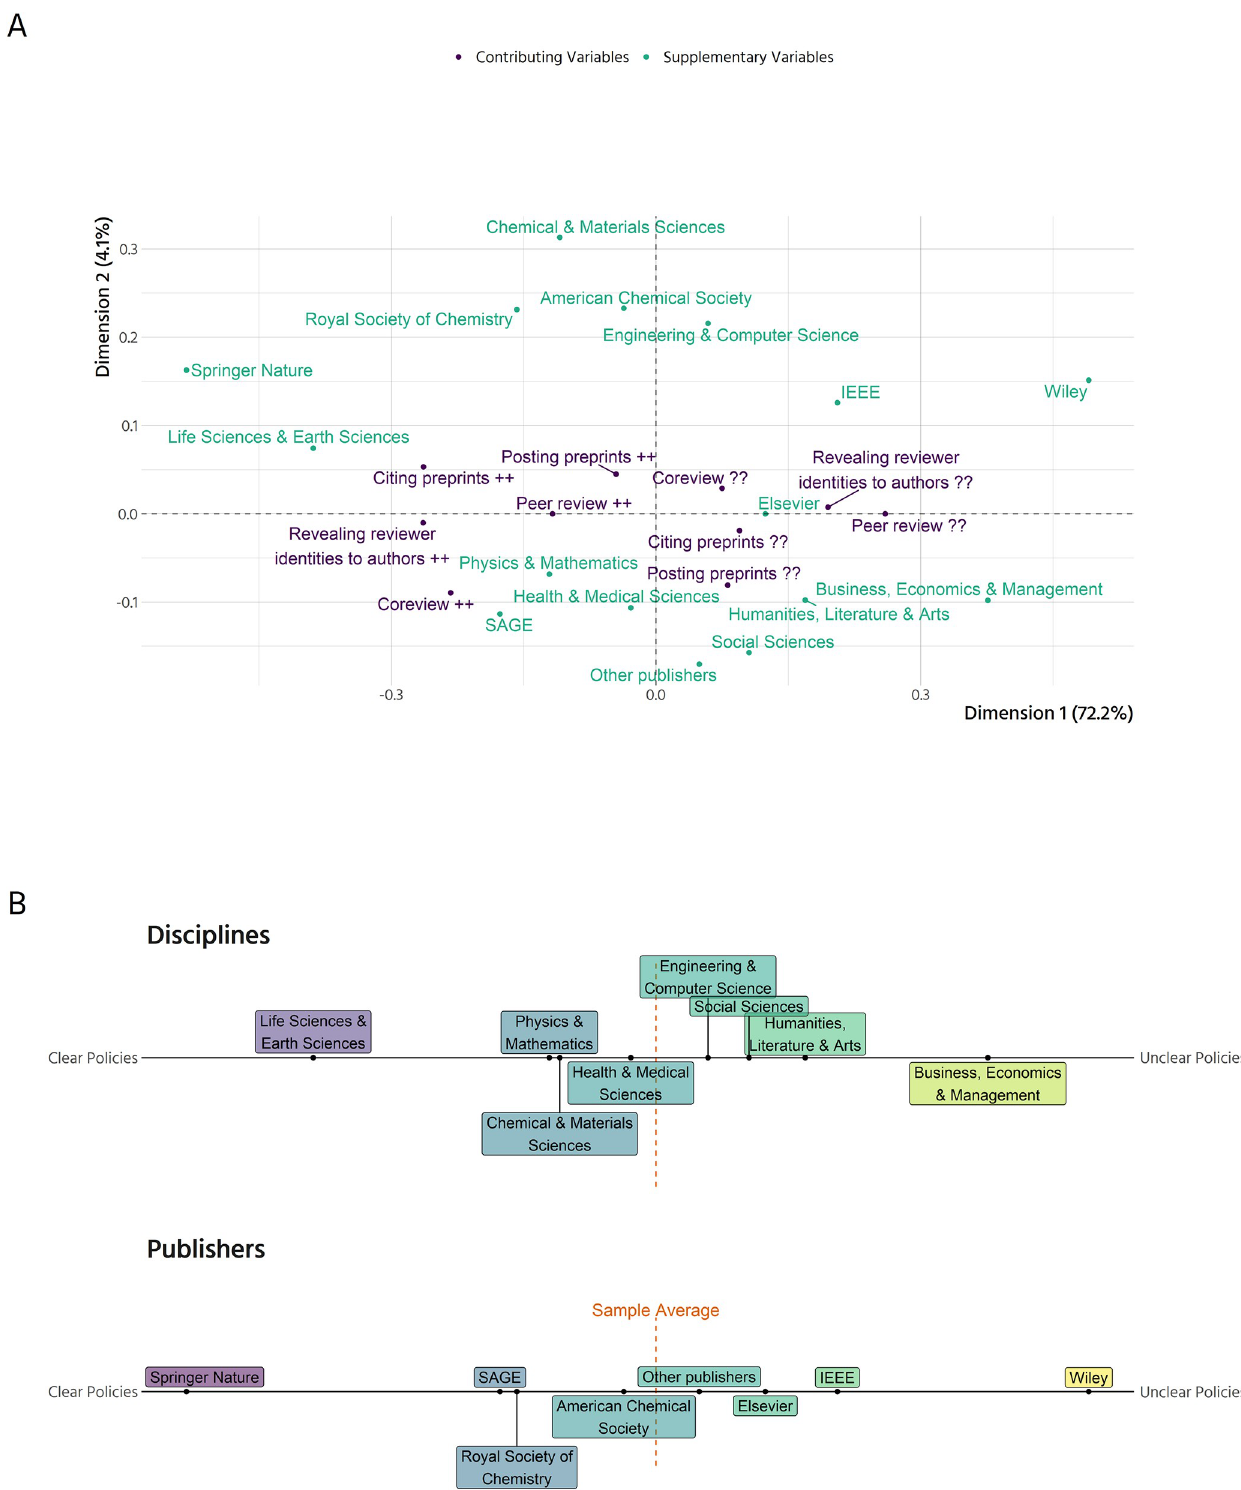
Fig 2. The landscape of open research policies. (A) Graphical display of a Multiple Correspondence Analysis. The contributing variables are the basis for the model and determine the layout of the space. "++" means that there is a clear policy, "??" that there is no clear policy. Disciplines and publishers were added as supplementary (passive) variables and have no impact on the space. Dimension 1 (horizontal) explains 72.2% of the variance, Dimension 2 explains 4.1% of the variance in the contributing variables. (B) The supplementary variables from (A) projected onto the horizontal axis. Journals from disciplines and